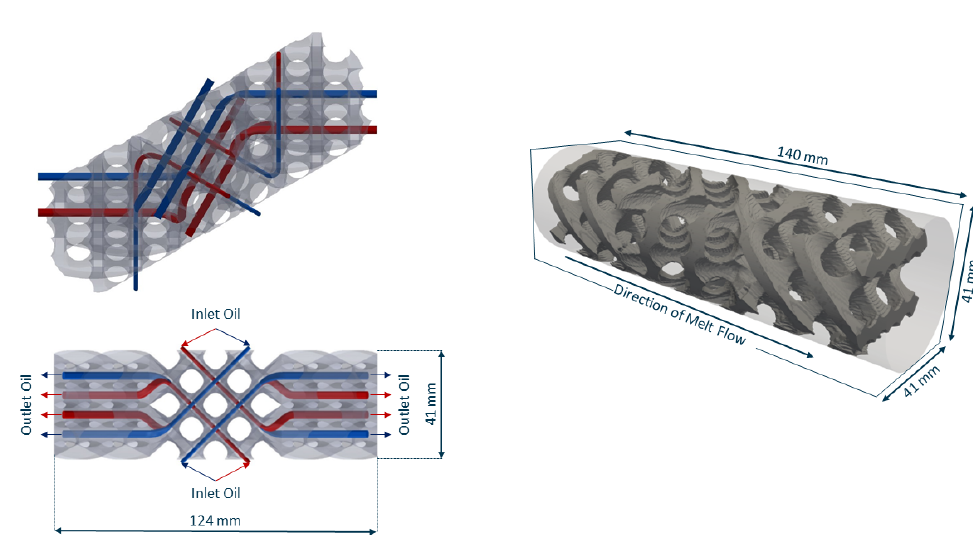
Figure 4. ( Left ) position and direction of flow of oil channels. ( Right ) Computational domain and reference geometry as immersed boundary field.